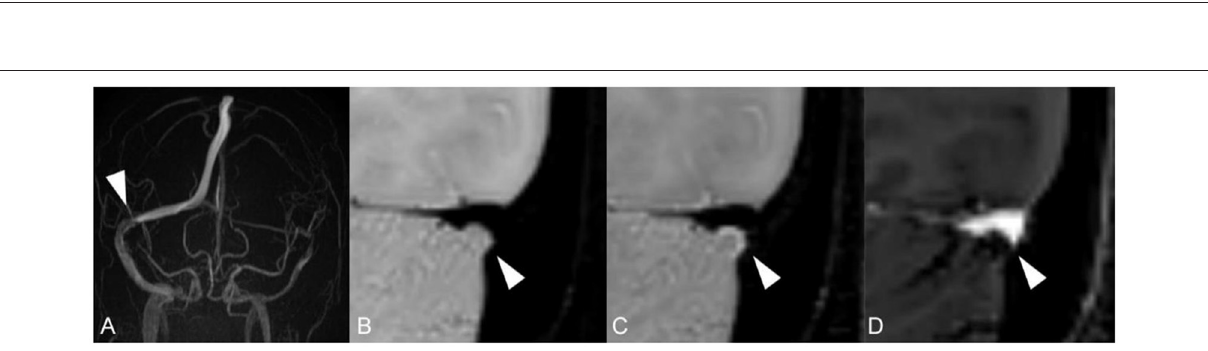
FIGURE 4 | Images reveal intra-sinus brain herniation in 46-year-old woman with headache and blurred vision. (A) MRV shows occlusion/ hypoplasia on LTS with normal RTS; (B) T1w black-blood image shows a small herniation of cerebellum parenchyma with surrounding CSF into RTS that was isointense on T1w; (C) T1w black-blood contrast-enhanced image shows a hyperintense margins surrounding the brain herniation; (D) T1w enhanced image shows a focal filling defect.